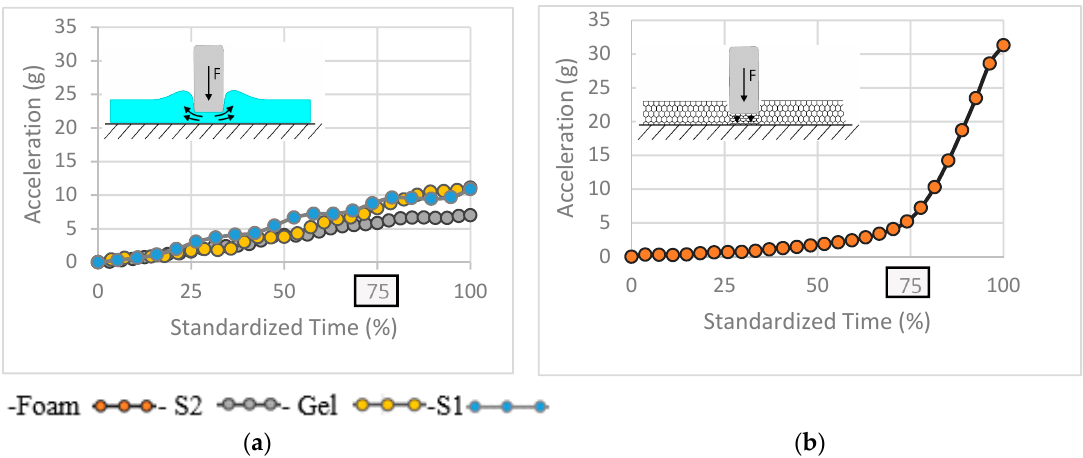
Figure 5. ( a ) Acceleration rate from beginning contact to impact peak (S1, S2 and G) and an illustration of compression behavior; ( b ) Acceleration rate from beginning contact to impact peak insole E and an illustration of compression